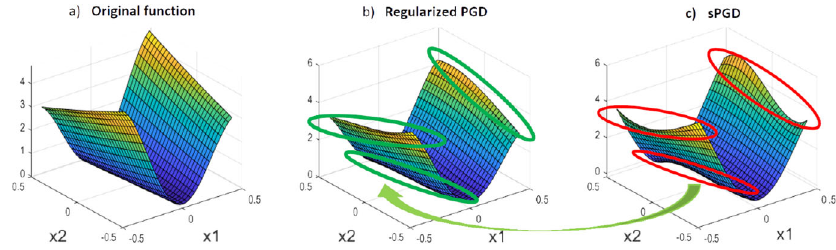
Fig. 4 Comparing the reference (Eq. (4.1)) and its associated s -PGD and rs -PGD regressions, at